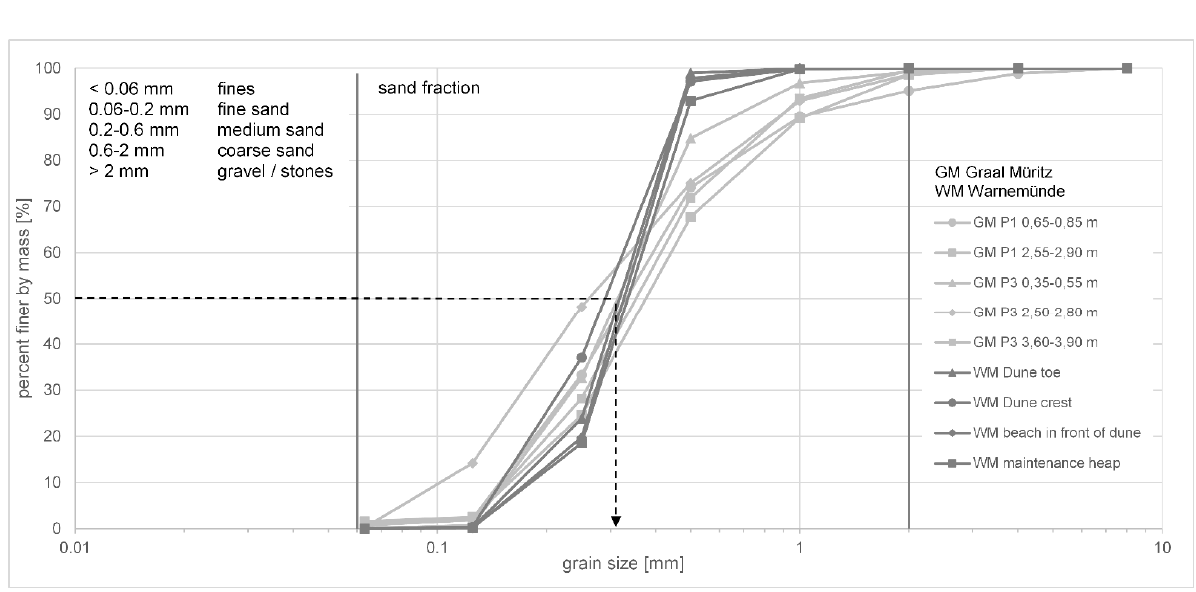
Figure 4. Representative grain size distributions for Warnemünde and Graal-Müritz dune/beach sand.